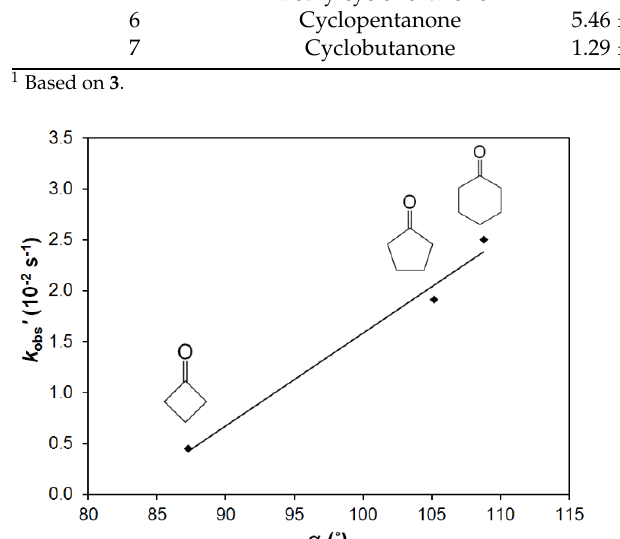
Table 6. Reaction rates determined in the reactions of 3 PhIO with various cycloketones in MeCN at 15 ◦ C. Entry Substrate k ox (10 − 2 s − 1 ) Yield (%) 1 1 ( μ -oxo)( μ -1,2-peroxo)diiron(III)-mediated Baeyer–Villiger reaction ( Δ H ≠ = 22 ± 1 kJ mol − 1 and Δ S ≠ = − 170 ± 10 J mol − 1 K) [39]. Table 7. Kinetic data for the stoichiometric Baeyer–Villiger oxidation of cyclohexanone with 3 PhIO Figure 9. Stoichiometric Baeyer–Villiger oxidation of cycloketone derivatives: ( a ) Absorbance change and 3 H2O2 . at 760 nm versus time in the 3 PhIO -mediated oxidation of cyclohexanones: without substrate (a), 4- tert -Butylcyclohexanone (b), 3-Methylcyclohexanone (c), 2-Methylcyclohexanone (d), Cyclohex- anone (e), 4-Methylcyclohexanone (f). Reaction conditions: [ 3 ] = 10 − 3 M, [sub.] = 0.35 M, at 15 °C; ( b ) Absorbance change at 760 nm versus time in the 3 PhIO -mediated oxidation of cycloketones: without substrate (a), cyclobutanone (b), cyclopentanone (c), cyclohexanone (d). Reaction conditions: [ 1 ] = 10 − 3 M, [sub.] = 0.35 M, T = 15 °C, the intermediate was generated with PhIO in MeCN.